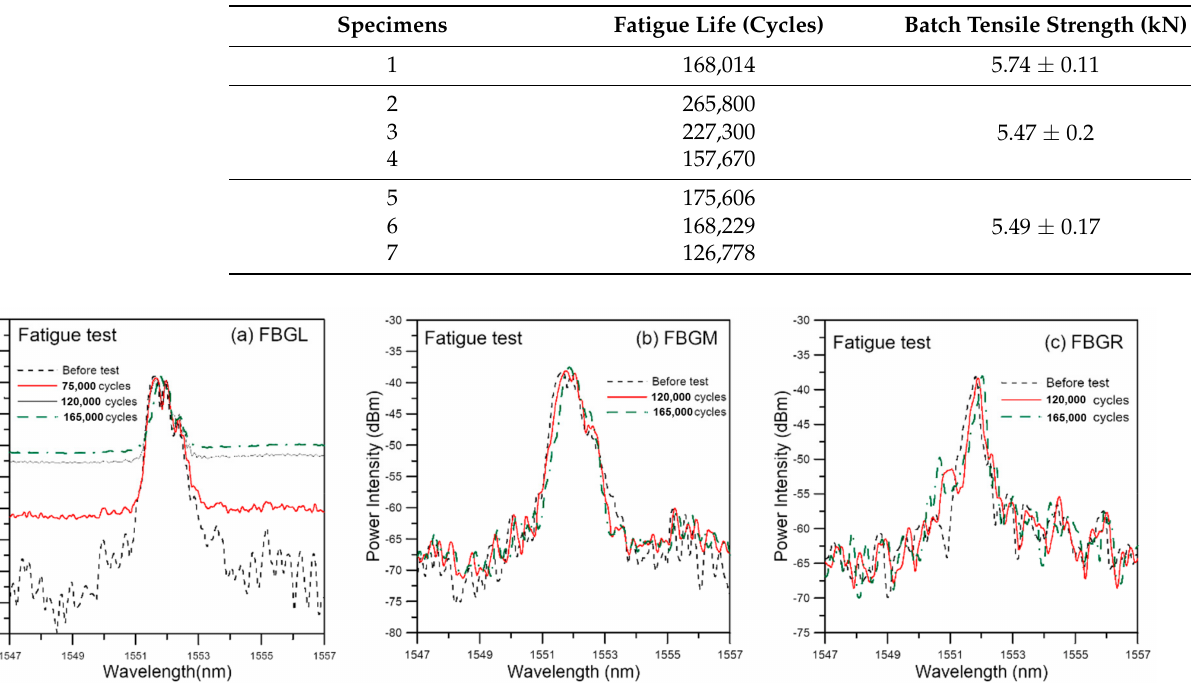
Table 1. Fatigue lives and the average batch tensile strength of virgin specimens tested. Specimens